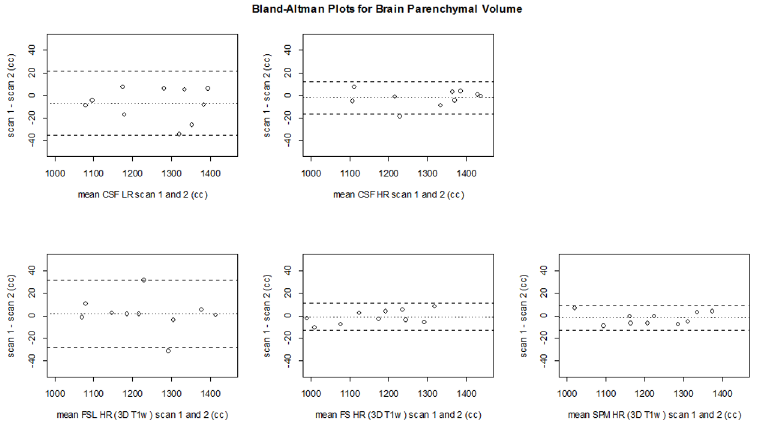
Fig 8. Bland Altman plots for precision of ICV per method. CSF LR, CSF HR (top row), FSL, FreeSurfer and SPM (bottom row). The dashed lines represent the limits of agreement (mean difference ±1.96 (cid:3) SD of the differences). CSF LR = CSF low resolution MRI scan; CSF HR = CSF high resolution MRI scan; FS = FreeSurfer.